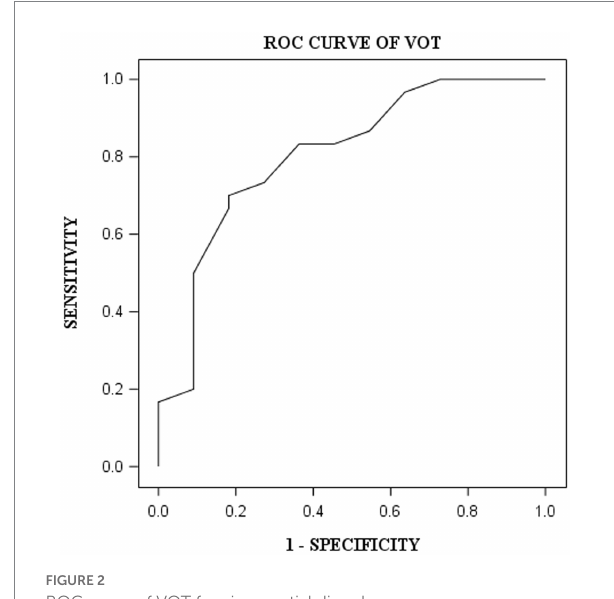
FIGURE 1 ROC curve of DST for visuospatial disorder.